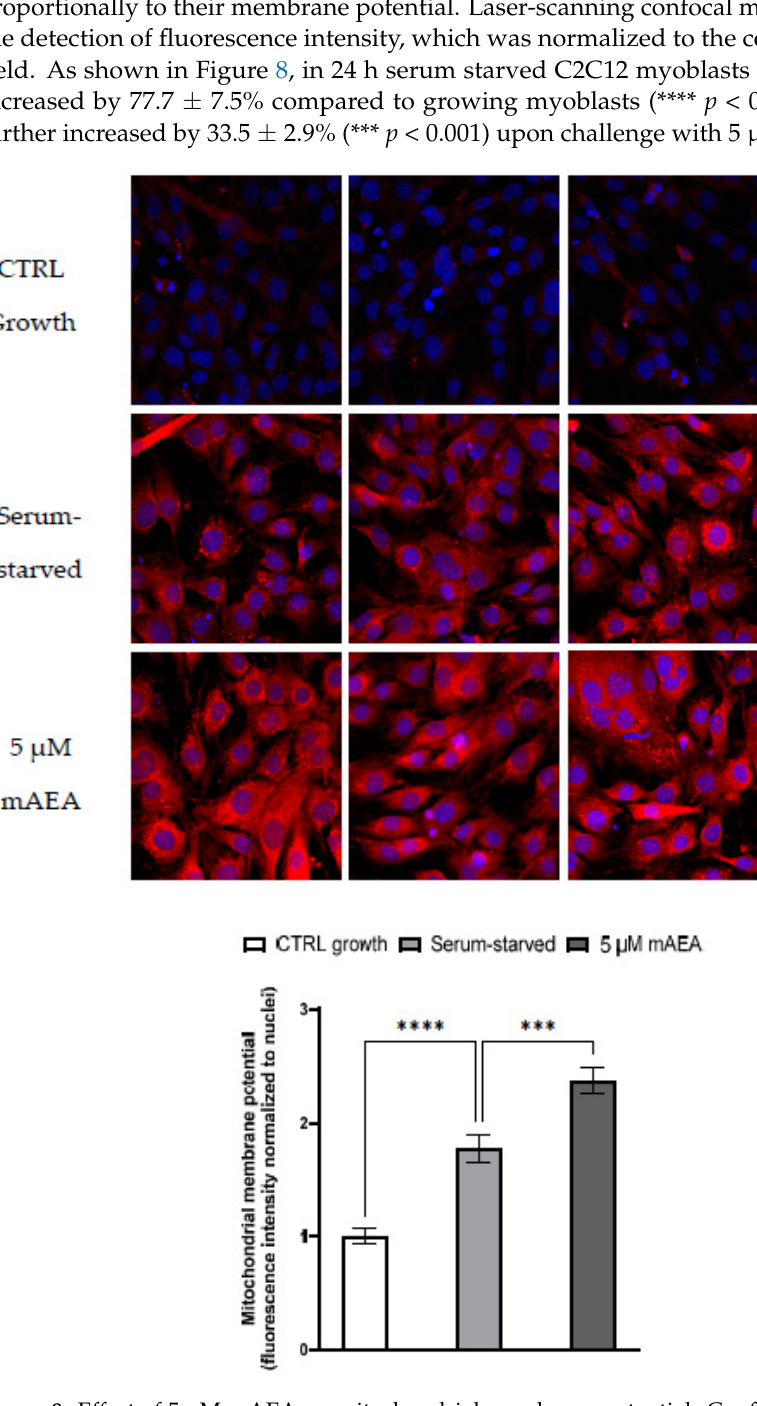
Figure 8. Effect of 5 µ M mAEA on mitochondrial membrane potential. Confluent serum-starved C2C12 myoblasts were treated, or not, with 5 µ M mAEA for 24 h and compared to growing (CTRL growth) myoblasts. Fluorescence intensity of Mitotracker Red CMX-Ros (Ex/Em: 579/599) was normalized to cell number and data are reported as mean ± SEM of six field per condition in each of the three independent experiments. Statistical analysis was performed by ONE-WAY ANOVA followed by Bonferroni post-hoc test [*** p < 0.001, **** p < 0.0001].